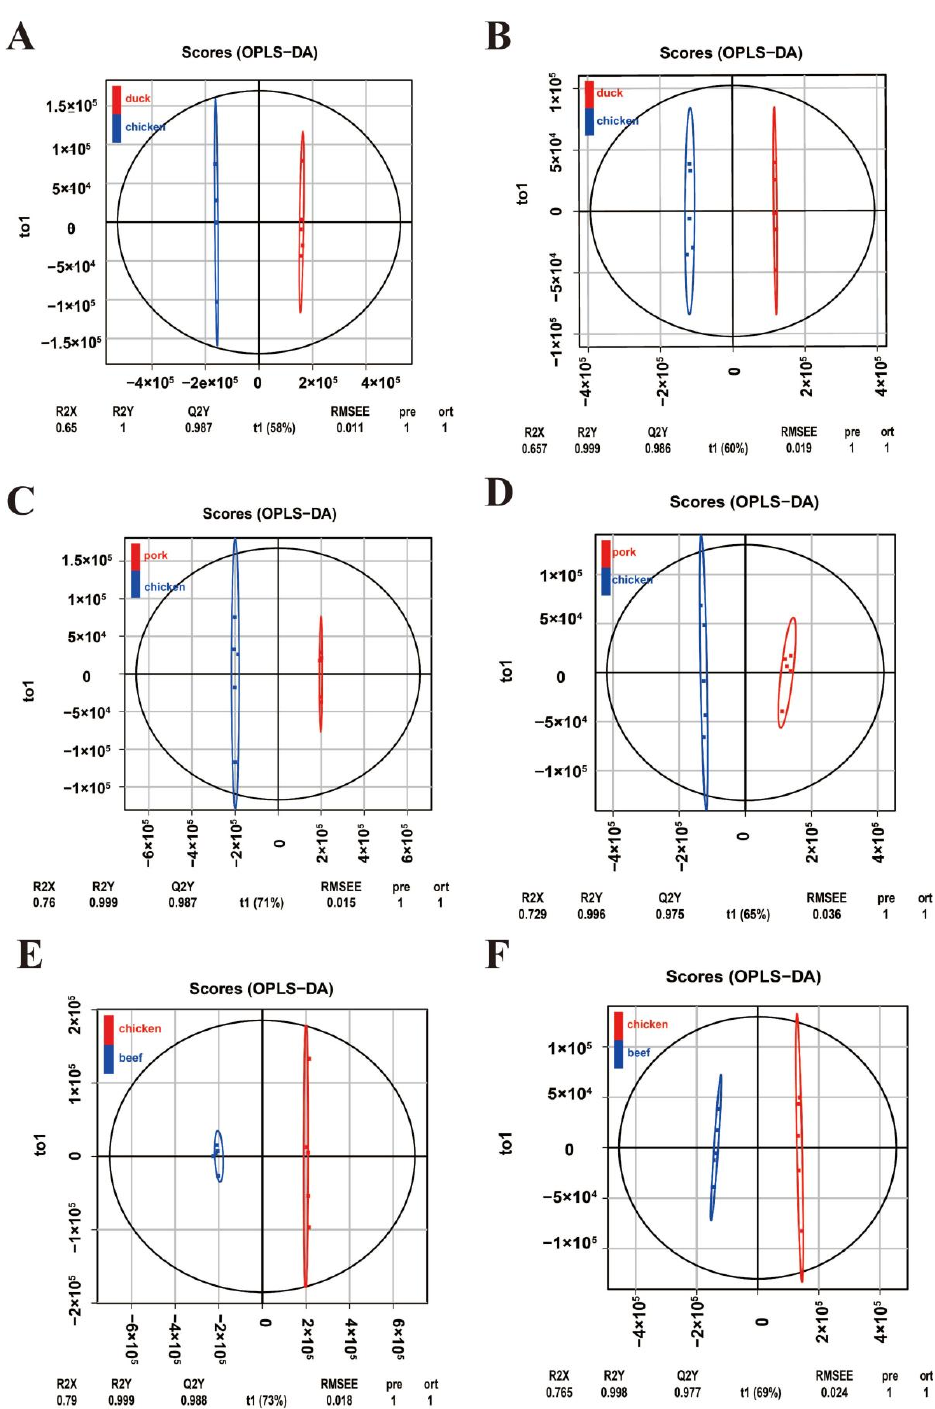
Figure 3. Orthogonal partial least squares discriminant analysis (OPLS-DA) of metabolites between groups. Metabolic differences between chicken and duck meat under positive ion ( A ) and negative ion ( B ) modes. Metabolic differences between chicken and pork under positive ion ( C ) and negative ion ( D ) modes. Metabolic differences between chicken and beef under positive ion ( E ) and negative ion ( F ) modes.